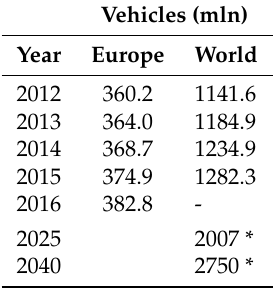
Table 1. Vehicles in use (in millions) in Europe and worldwide. Source: ACEA, OICA, and